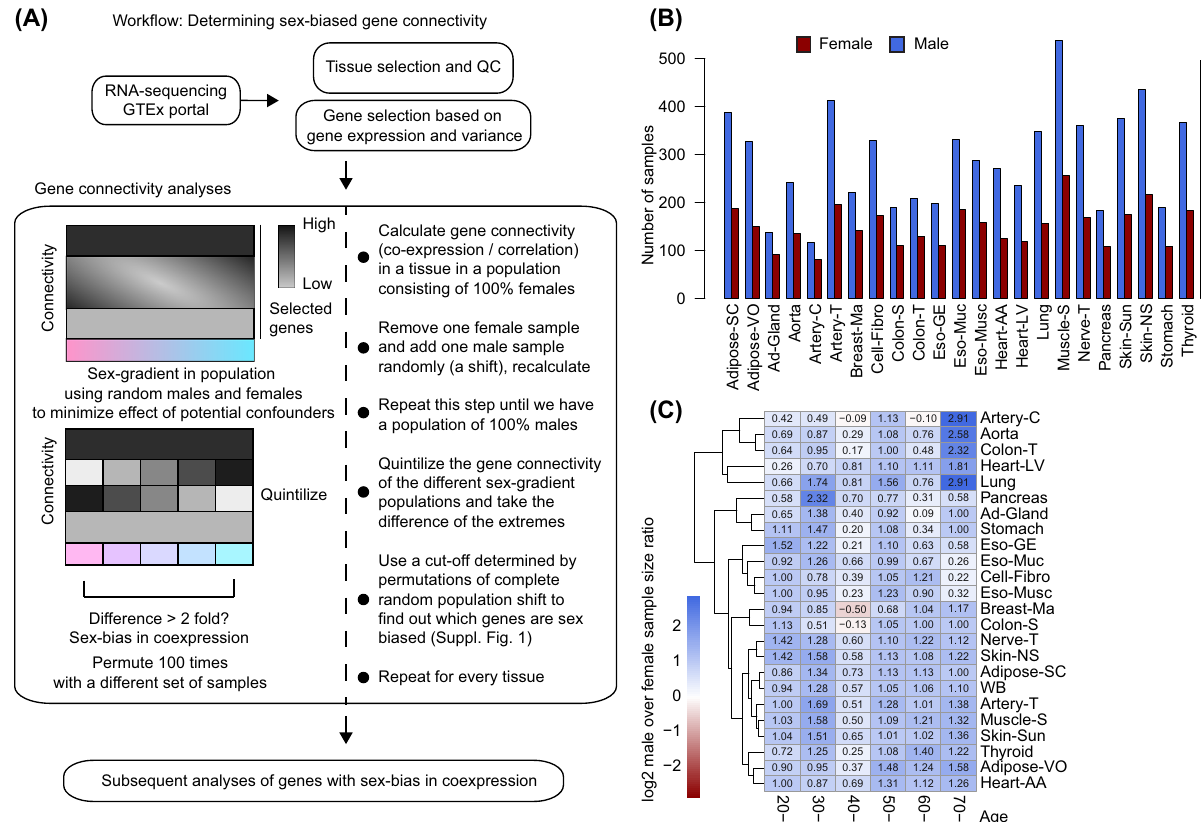
Figure 1. Workflow of sex-stratified gene co-expression analyses. ( A ) The workflow of analyses performed in this study are shown. We started by analysing publicly available RNA-sequencing data from the GTEx Portal. We selected tissues with a RIN > 6.0, and with at least 80 samples of both sexes. Subsequently, we determined sex-biased gene co-expression in those 24 tissues that met our criteria as elaborated upon in the large box. See Suppl. Fig. 1A. for an in depth workflow. ( B ) The amount of samples used over the 24 selected tissues is shown in a barplot. Red indicates female, blue indicates male. ( C ) Log 2 sex-ratios (male over female) are shown in a heatmap. The rows show the tissues, while the columns indicate age